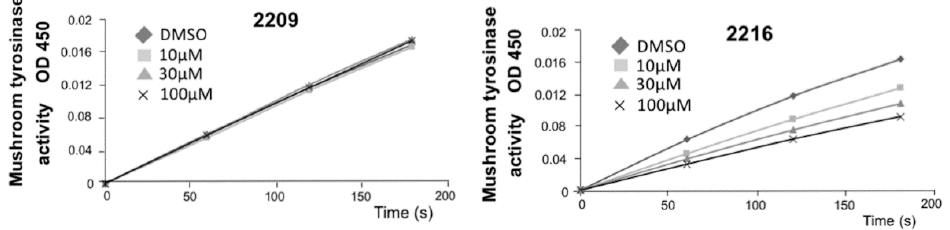
Figure 8 . The reliability of the tyrosinase assay system was verified with mushroom tyrosinase (4.15 U).